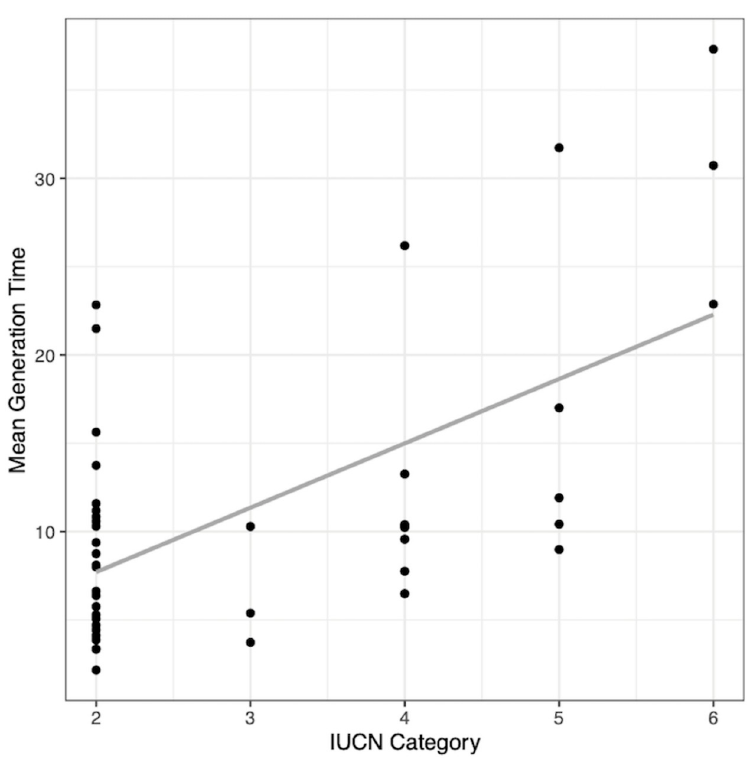
Fig 3. Relationship between endangered status and the most important predictor for mammals. Mean generation time is the most important predictor of endangered status for 43 mammal species and is positively correlated to IUCN Red List categories. See Fig 1 for descriptions of trend lines and IUCN